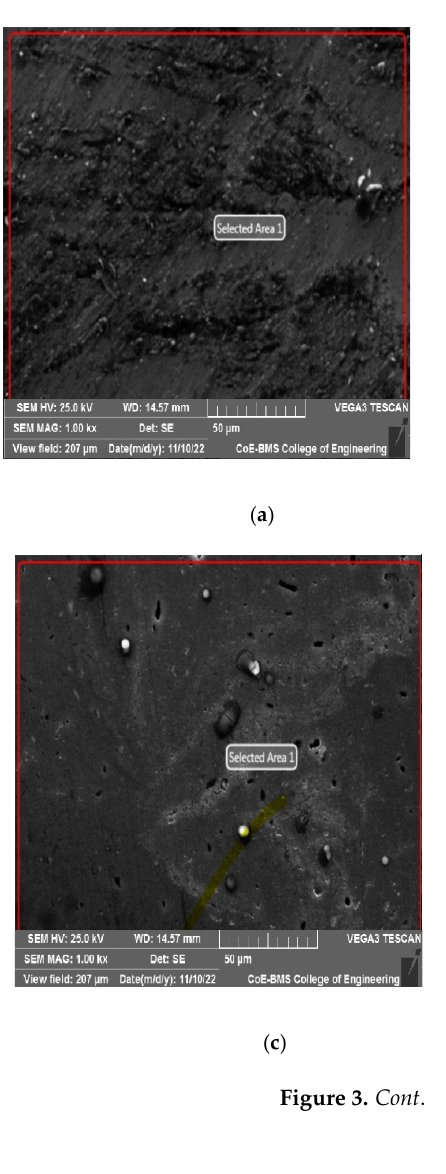
( f ) Figure 3. XRD analysis of ( a ) selected area and ( b ) EDAX of AA7075/n-B4C; ( c ) selected area and ( d ) EDAX of AA7075/n-TiO 2 ; ( e ) selected area and ( f ) EDAX of AA7075/n-Gr.